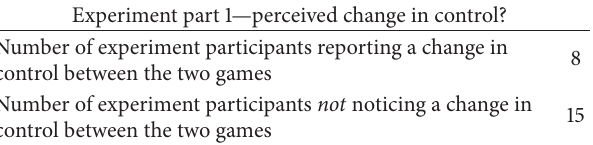
Table 8: Numbers of experiment participants reporting a change